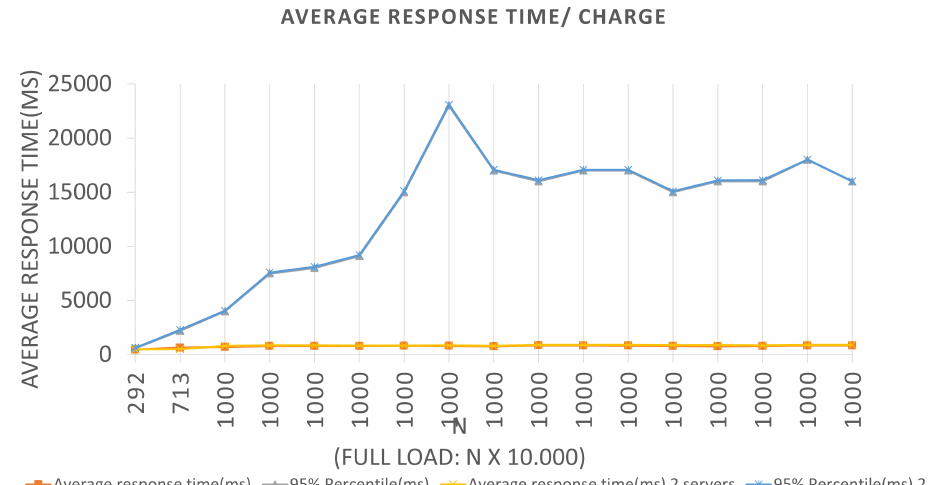
Figure 14. Results of the experiments for query loads.